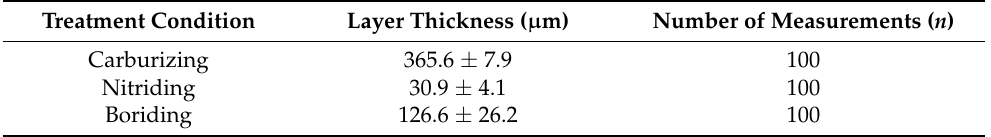
Table 6. Thickness of the hardened layers as a function of the different hardening